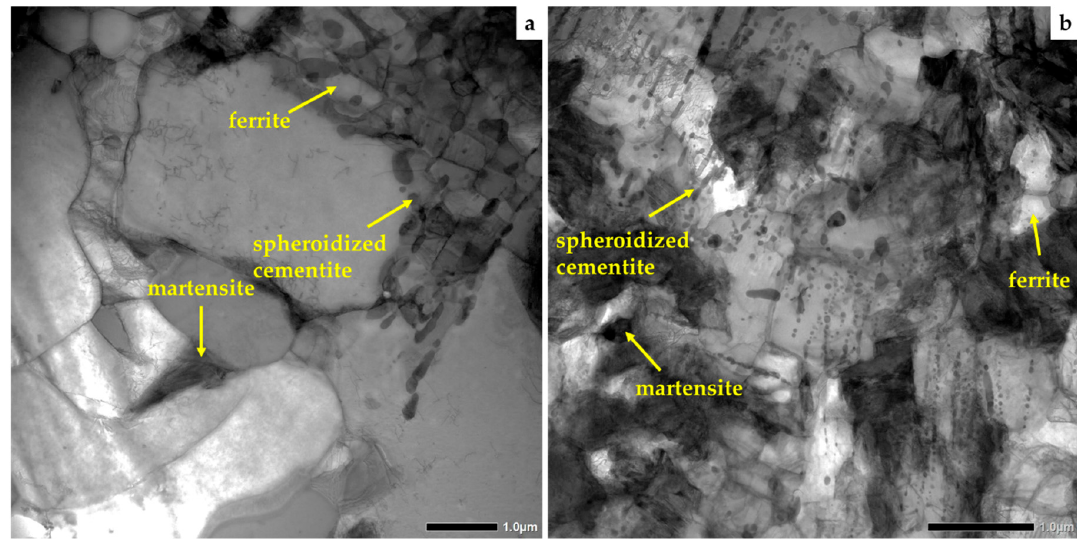
Figure 12. ( a ) Undissolved spheroidized cementite in the microstructure of the CH sample is leading to grain refinement, as it impedes the movement of GBs during heating. ( b ) The same case for the UFH sample with the only difference that cementite maintains its lamellar morphology to a greater extent.